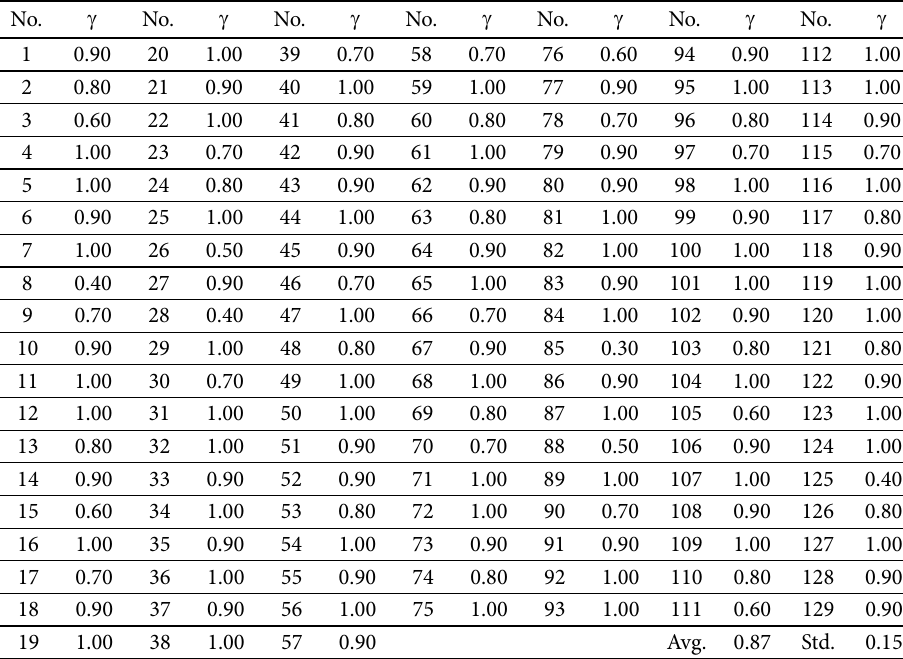
Table 11. Results for Spearman rank correlation